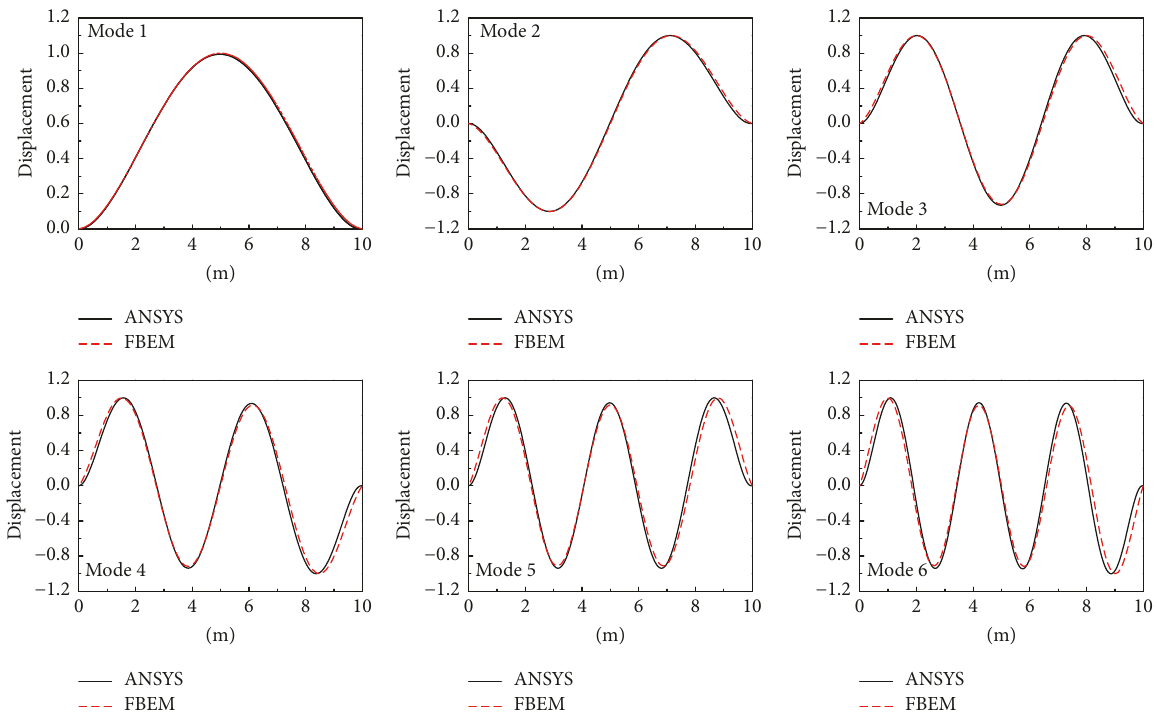
Figure 6: Comparison between the first six flexural modes of ANSYS and FBEM models of